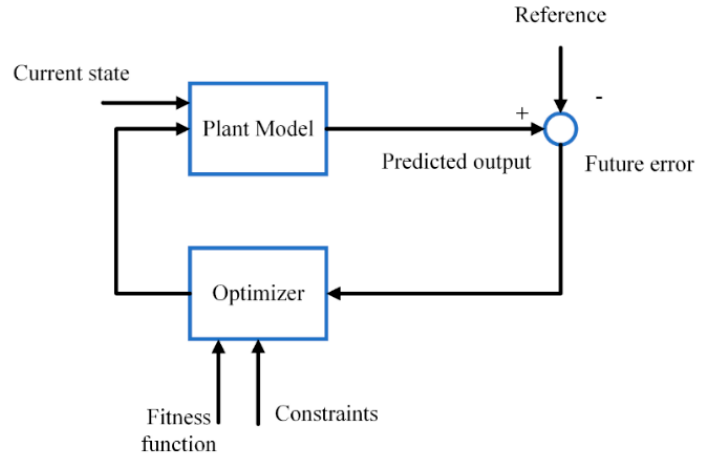
Figure 6. Model predictive control strategy .